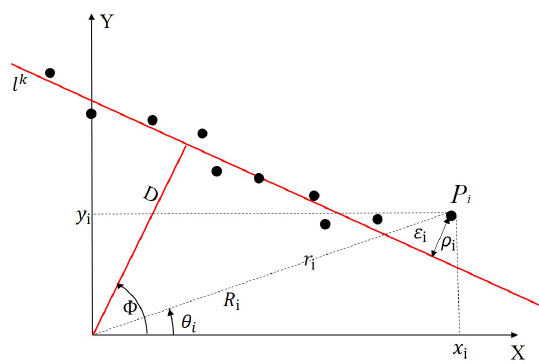
Figure 3. Schematic diagram of weighted iterative. A red line l k represents the intersection between the laser scanning plane and a plane of the trihedron. Some black points represent the laser points that do not coincide with the red line because of the influence of the ranging noise. The Cartesian coordinates system represents the scanning plane of the